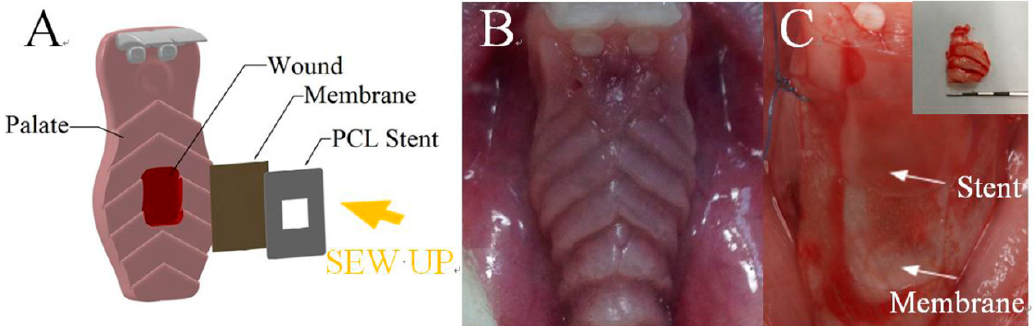
Figure 1. ( A ) Schematic of the deployment of biodegradable stent and nanofibrous membrane on the donor site; and ( B ) beforel and ( C ) after the deployment of stent and membrane.